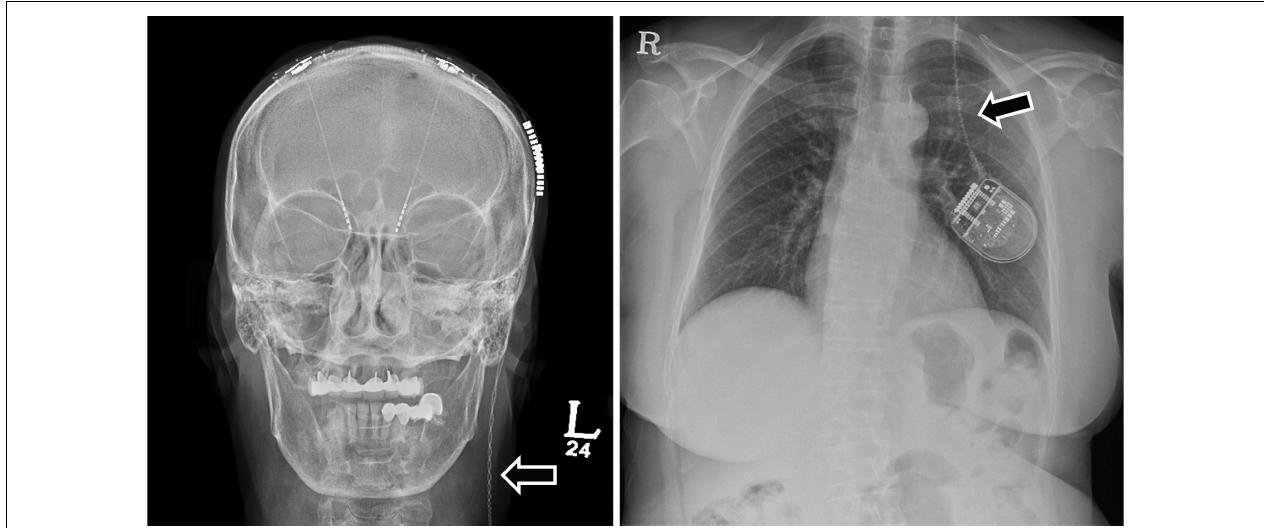
FIGURE 3 | A 70-year-old woman with Parkinson’s disease had a broken extension wire due to Twiddler’s syndrome 3 months after primary DBS surgery. The skull and chest X-rays demonstrate twisted and broken extension wires due to Twiddler’s syndrome (arrows). The patient underwent revision surgery to replace the extension wire and perform multiple firm internal pulse generator anchor sutures. DBS, deep brain